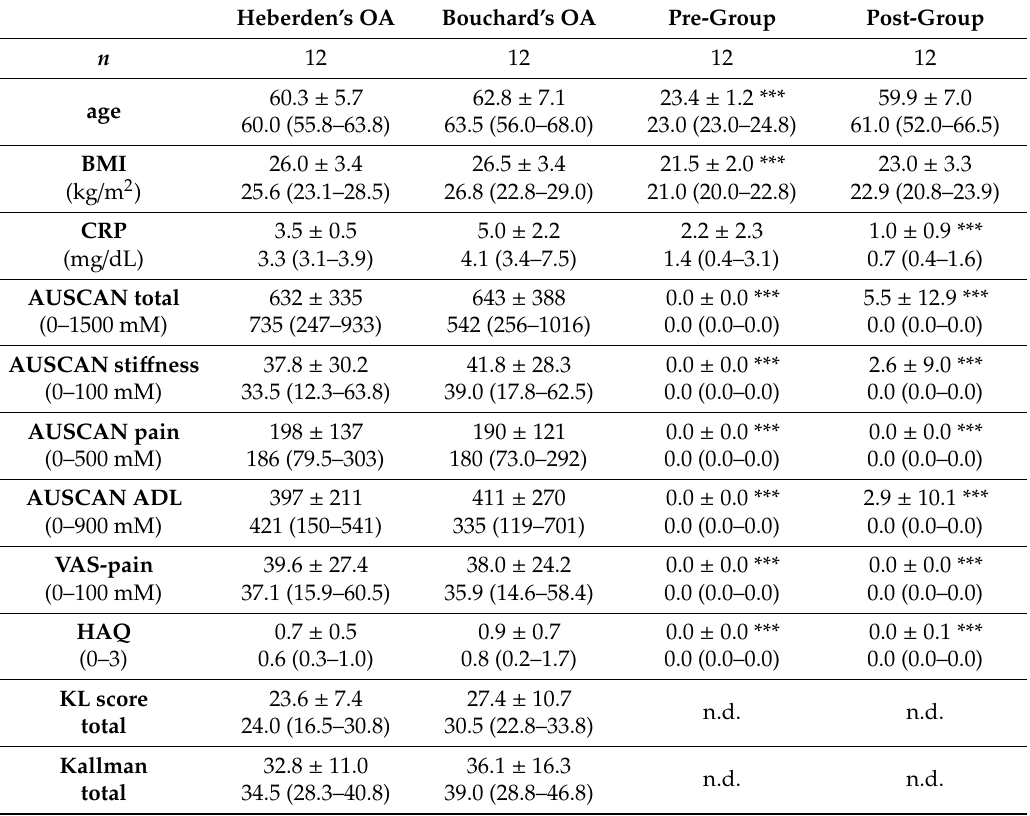
Table 1. Characterization of the study